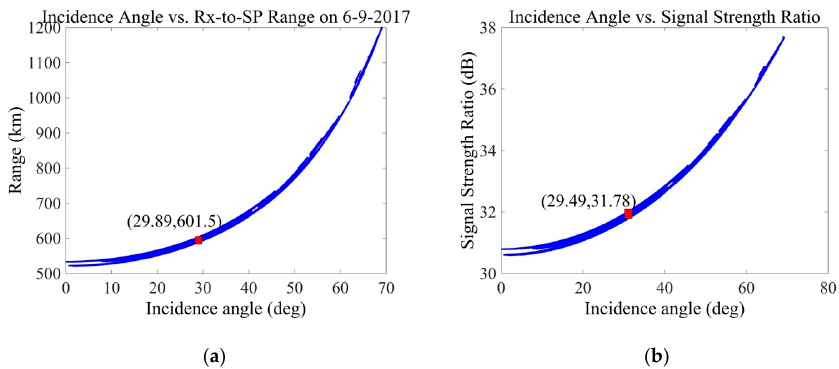
Figure 2. Dependence on incidence angle of: ( a ) propagation distances from specular point to receiver; ( b ) relative signal strength received from coherent and incoherent scenes for one full day of samples on 9 June 2017. The red dots indicate the incidence angles at which the greatest number of samples occurs.